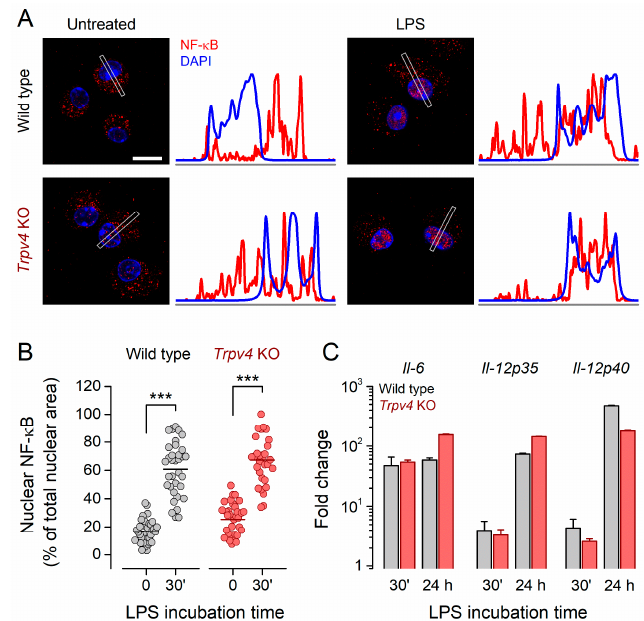
Figure 4. LPS-induced cytokine production occurred independently of TRPV4. ( A ) Representative confocal immunofluorescence microscopy images of fixed BMDCs untreated or treated with LPS (100 ng / mL). Cell stainings correspond to NF- κ B p65 (red) and DAPI (nuclear, blue). Scale bar, 10 µ m. The average linear intensity along the gray rectangle is represented next to the corresponding image. ( B ) Percentage of the total nuclear area stained by NF- κ B p65 staining. The horizontal bar represents the mean. ***, p < 0.001, Tukey’s multiple comparison test. ( C ) Relative expression of cytokines in WT and Trpv4 KO BMDCs after 30 min and 24 h incubation with 100 ng / mL of LPS. Expression levels were normalized to GAPDH and the genotype-matched untreated samples. The bars represent the mean ± SEM of three independent